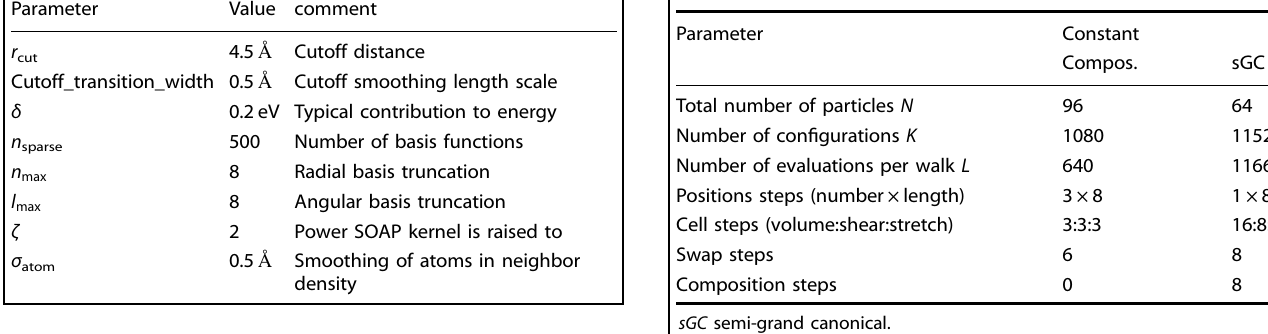
Table 4. Nested sampling parameters in the notation of ref. 41 for constant composition and sGC NS runs.